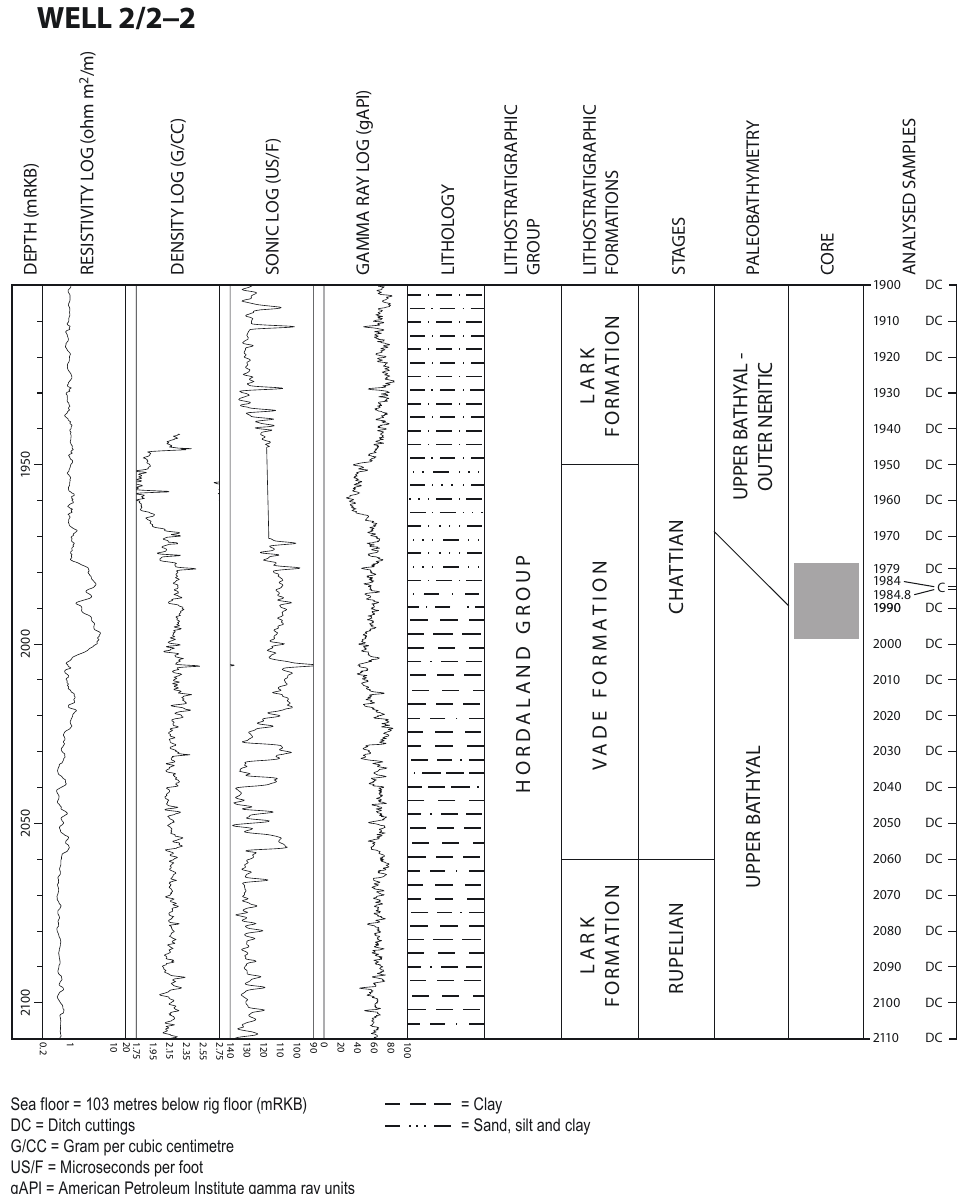
Figure 29. Well summary figure including resistivity log, density log, sonic log, gamma-ray log, lithology, litho- stratigraphic units, stages, paleobathymetry, core and analysed samples for the investigated sequence in well 2/2–2 (Rupelian to Chattian) including the supplementary well reference section for distal deposits of the Vade Formation (modified after Eidvin et al.,